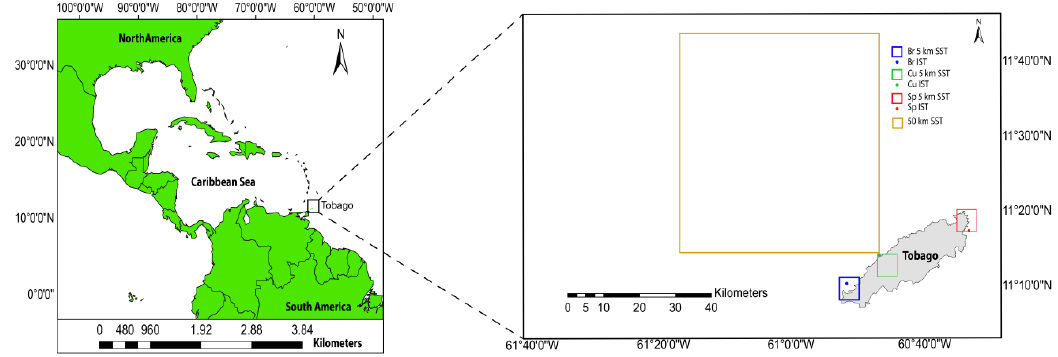
Figure 1. Locations of the three Tobago reefs and satellite pixels from which in situ temperature and sea surface temperature measurements, respectively, were analyzed. Blue, green and red represent Buccoo Reef (Br), Culloden (Cu) and Speyside (Sp), respectively, here and in the following figures.